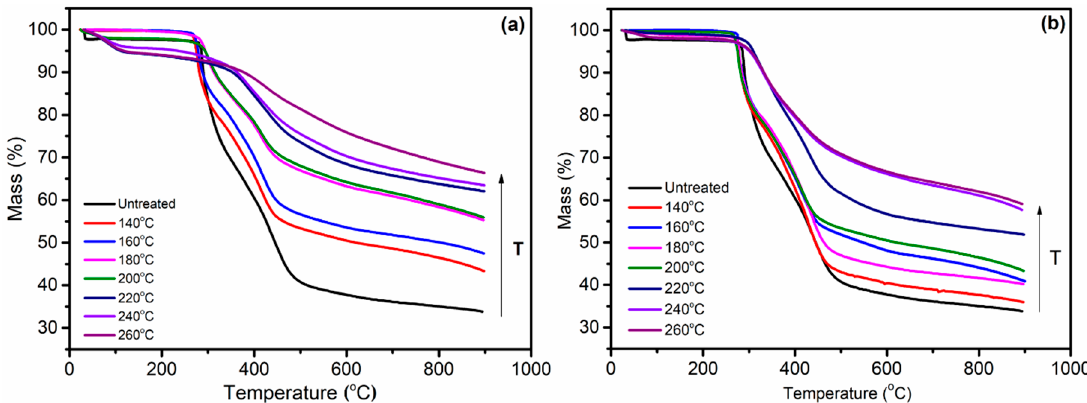
Figure 10. The thermogravimetric (TG) curves of PAN fibers treated at different temperatures: ( a ) in Sc-CO 2 ; ( b ) in air.